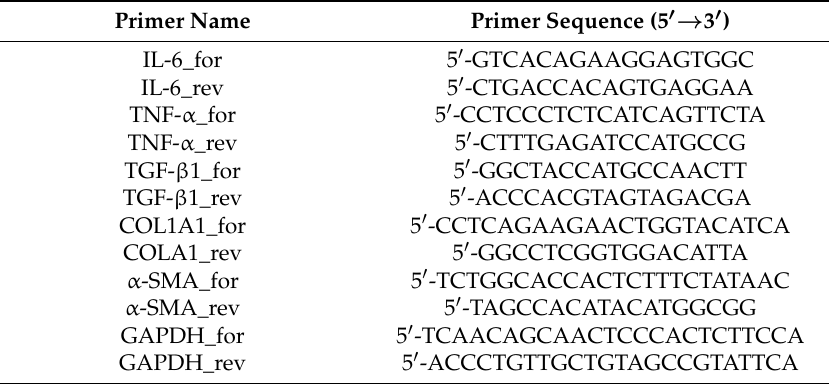
Table 2. Primers used in this